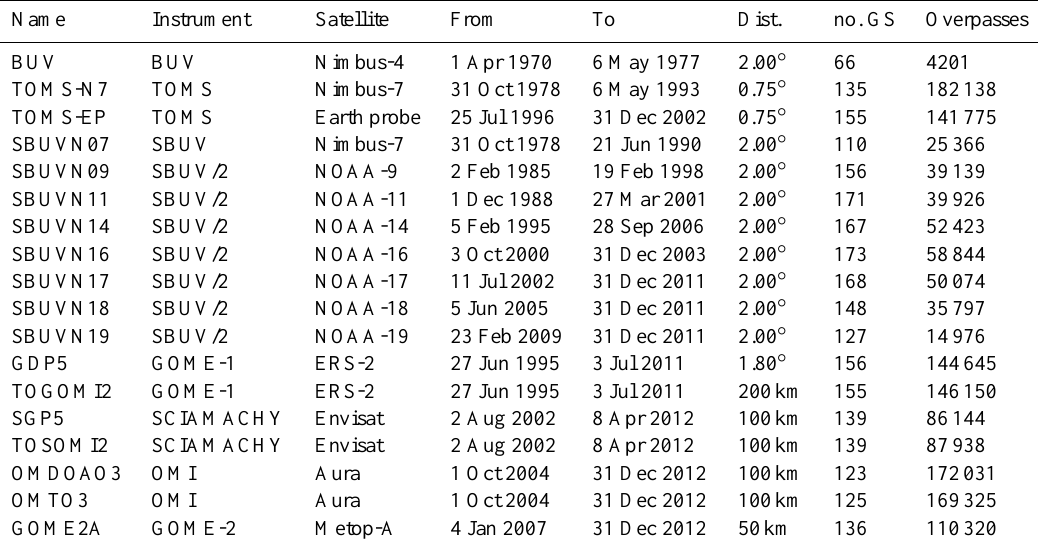
Table 1. The satellite data sets used in this study. The columns show (1) the name of the data set, (2) the satellite instrument, (3) the satellite, (4 and 5) the time period, (6) the maximum distance allowed in an overpass, (7) the number of ground stations (GS) and (8) the total number of overpasses for this data set.